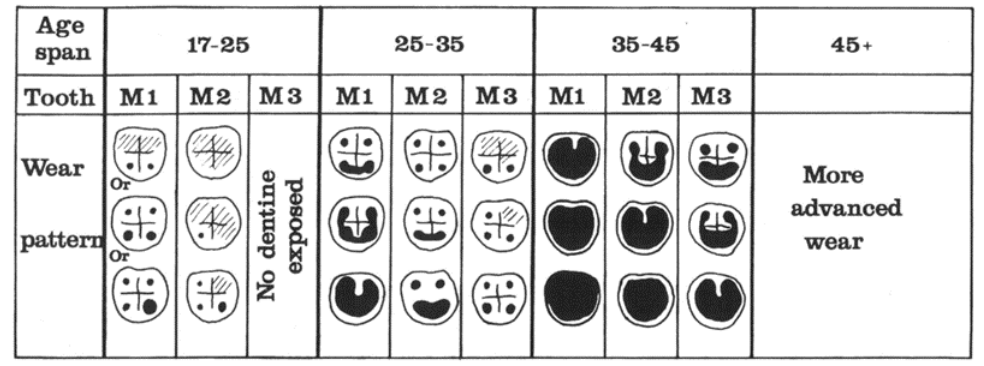
Figure 6. Estimated correspondence between adult age at death and molar wear phases for British material from Neolithic to medieval periods [35].